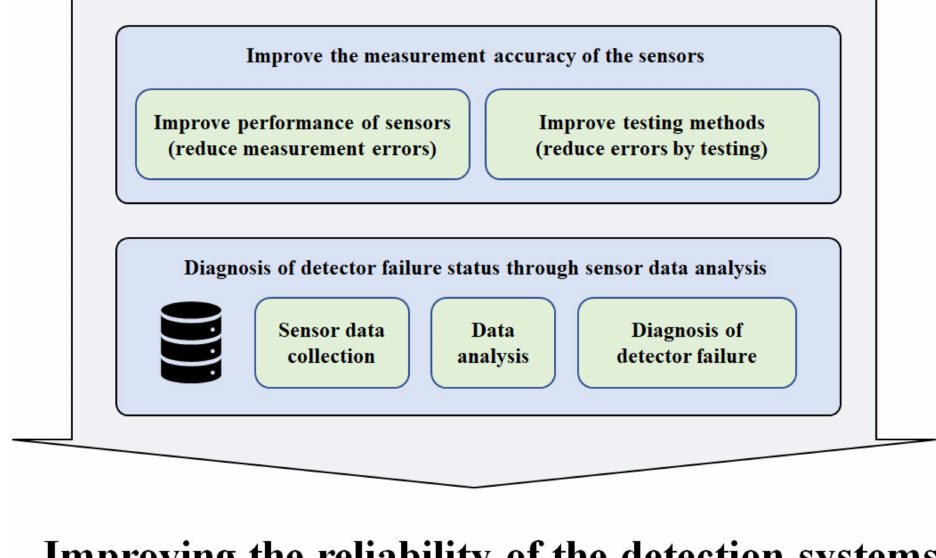
Figure 11. Improving the reliability of the detection